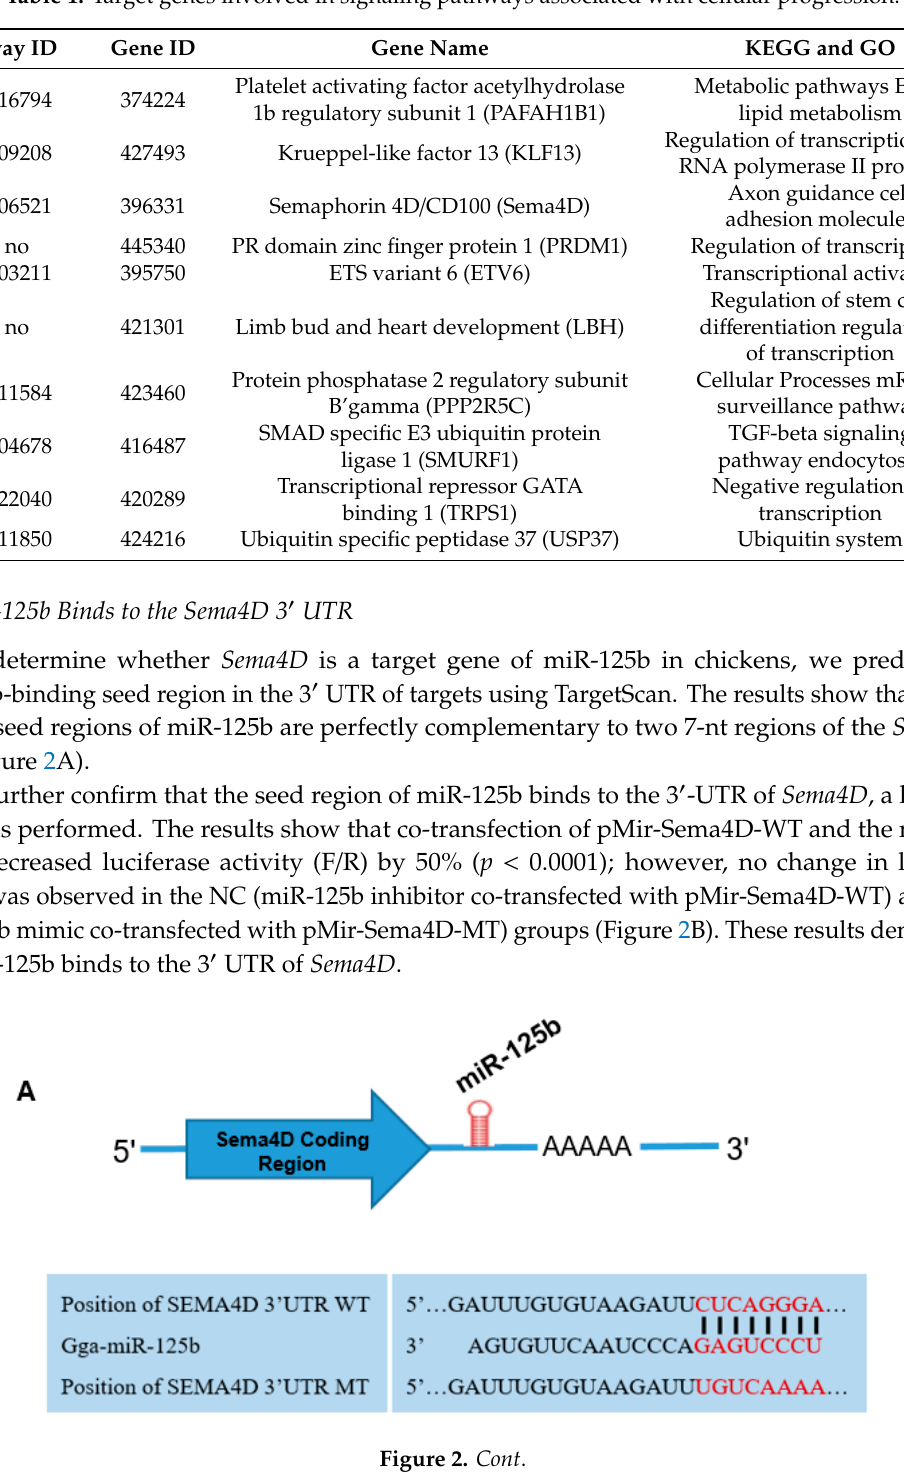
Table 1. Target genes involved in signaling pathways associated with cellular progression.